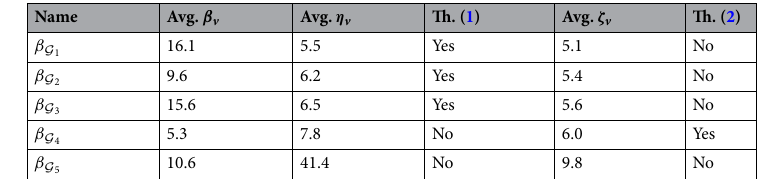
Table 6. Relationship between average self-regulation parameters β v and the thresholds of Theorems 1 and 2. Col. 2: the value β v averaged over a given group, over the R = 22 regions and over the 100 trials. Col. 3: the value of threshold η v averaged over a given group, over the R = 22 regions and over the 100 trials. Col. 4: Theorem 1 satisfaction (in average). Col. 5: the value ζ v averaged over a given group, over the R = 22 regions and over the 100 trials. Col. 6: Theorem 2 satisfaction (on